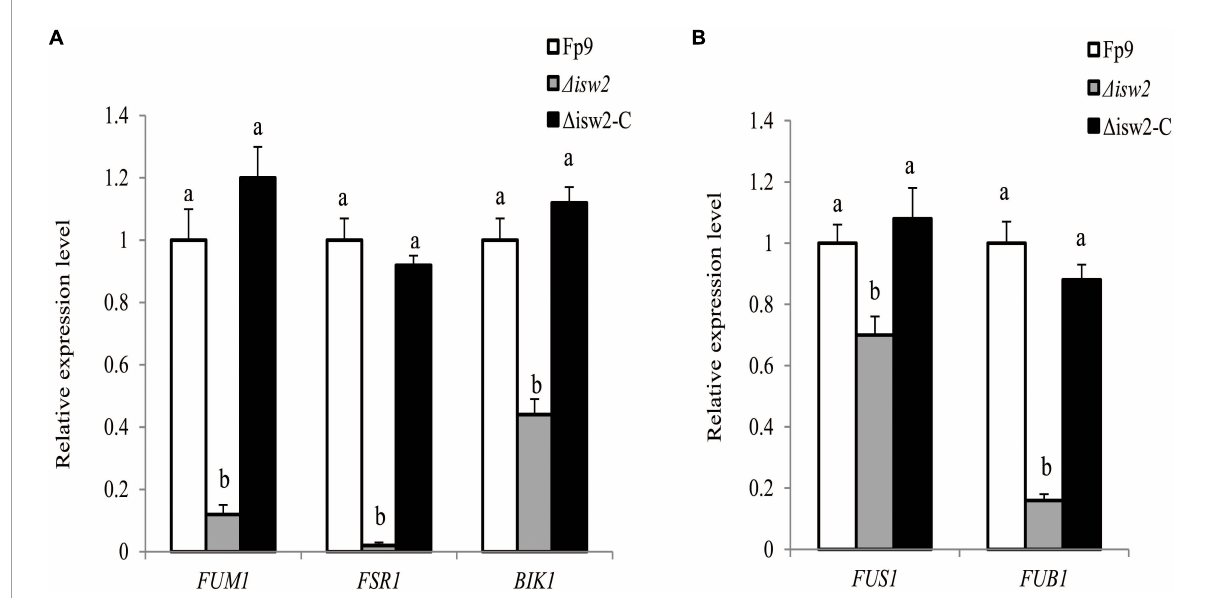
FIGURE9 ISW2 affected the expression of SM biosynthetic gene clusters. (A) Expression of FUM1 encoding fumonisin cluster-polyketide synthase, FSR1 encoding fusarubin cluster-polyketide synthase, and BIK1 encoding bikaverin cluster-polyketide synthase of (cid:49) isw2 mutant grown in YEPD media for 72 h before switching to DL cultures for 48 h with 6 mM glutamine as the sole nitrogen source. Its relative expression level in wild-type strain Fp9 was arbitrarily set to 1. Different letters on bars indicated a significant difference ( p < 0.05) with three biological replicates. (B) Expression of FUS1 encoding fusarin C cluster-polyketide synthase, FUB1 encoding fusaric acid cluster-polyketide synthase of (cid:49) isw2 grown in YEPD media for 72 h before switching to DL cultures for 48 h with 60 mM glutamine as the sole nitrogen source. Its relative expression level in wild-type strain Fp9 was arbitrarily set to